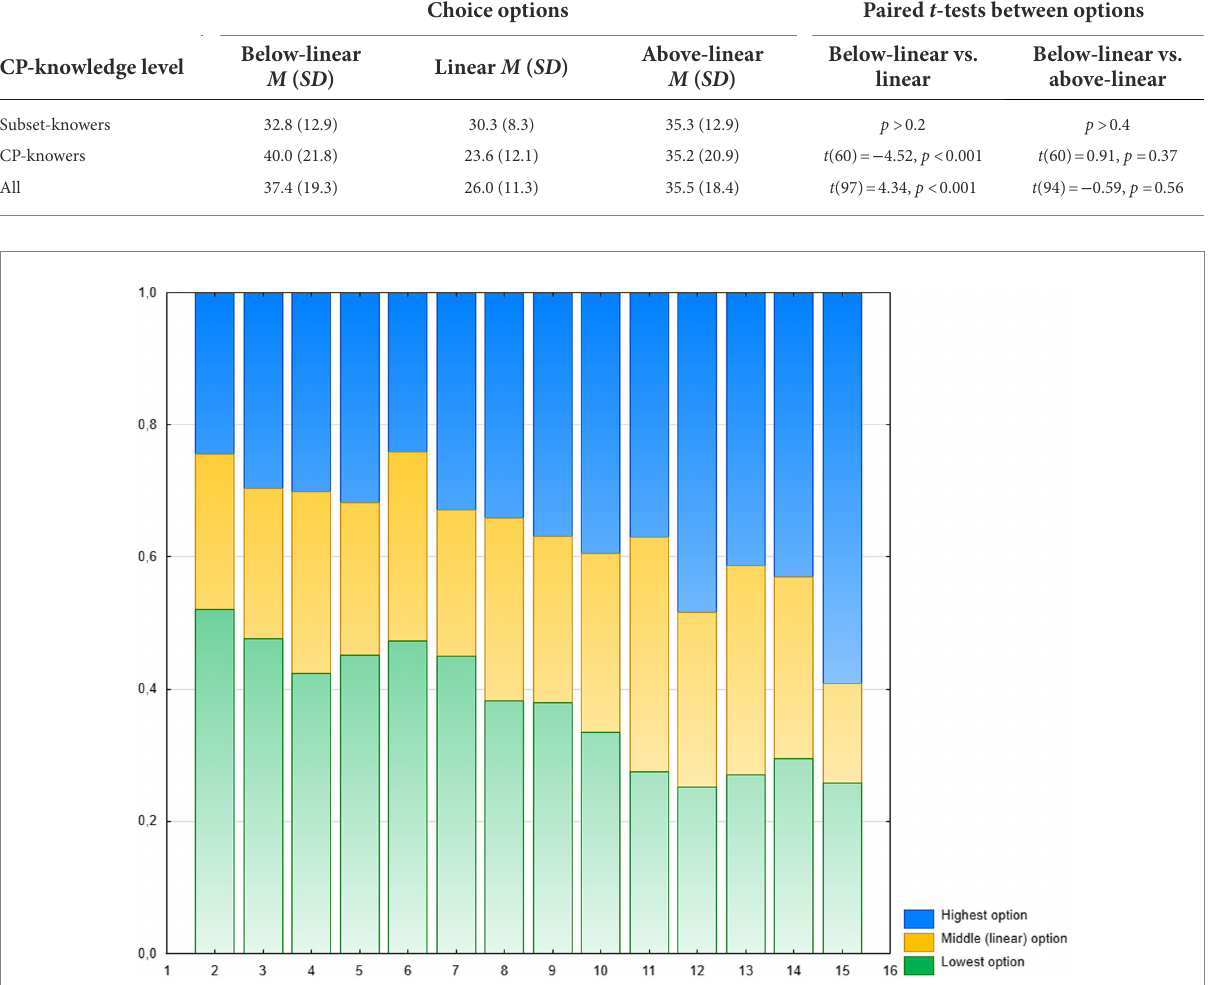
TABLE 3 Mean percentage, standard deviations, and t values of choices of below-linear, linear, and above-linear options.